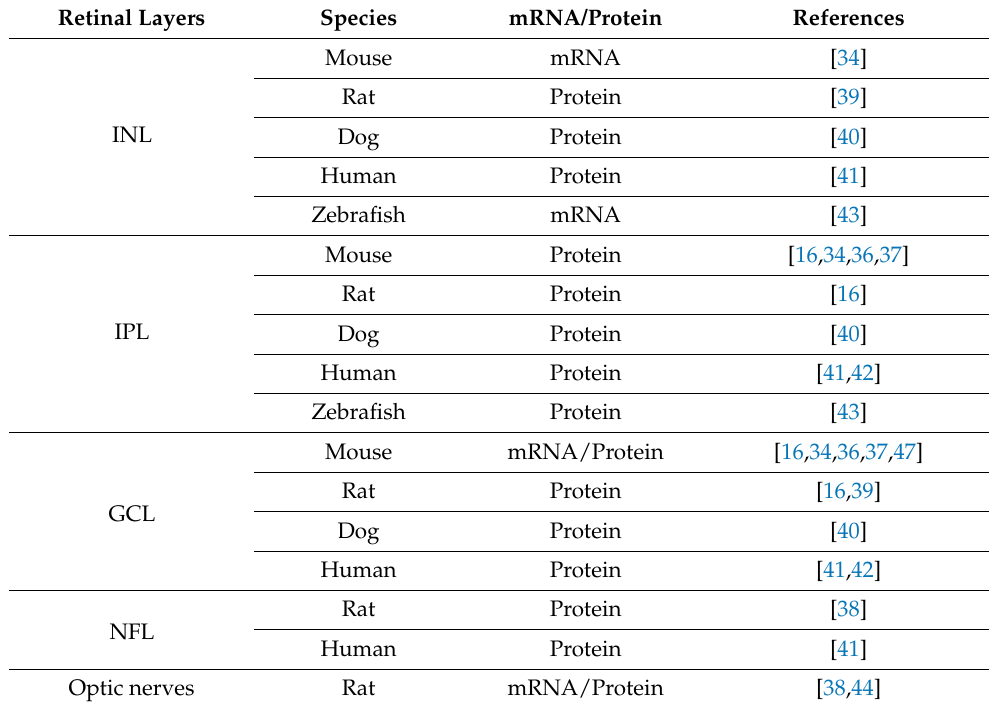
Table 1. Cont. Retinal Layers